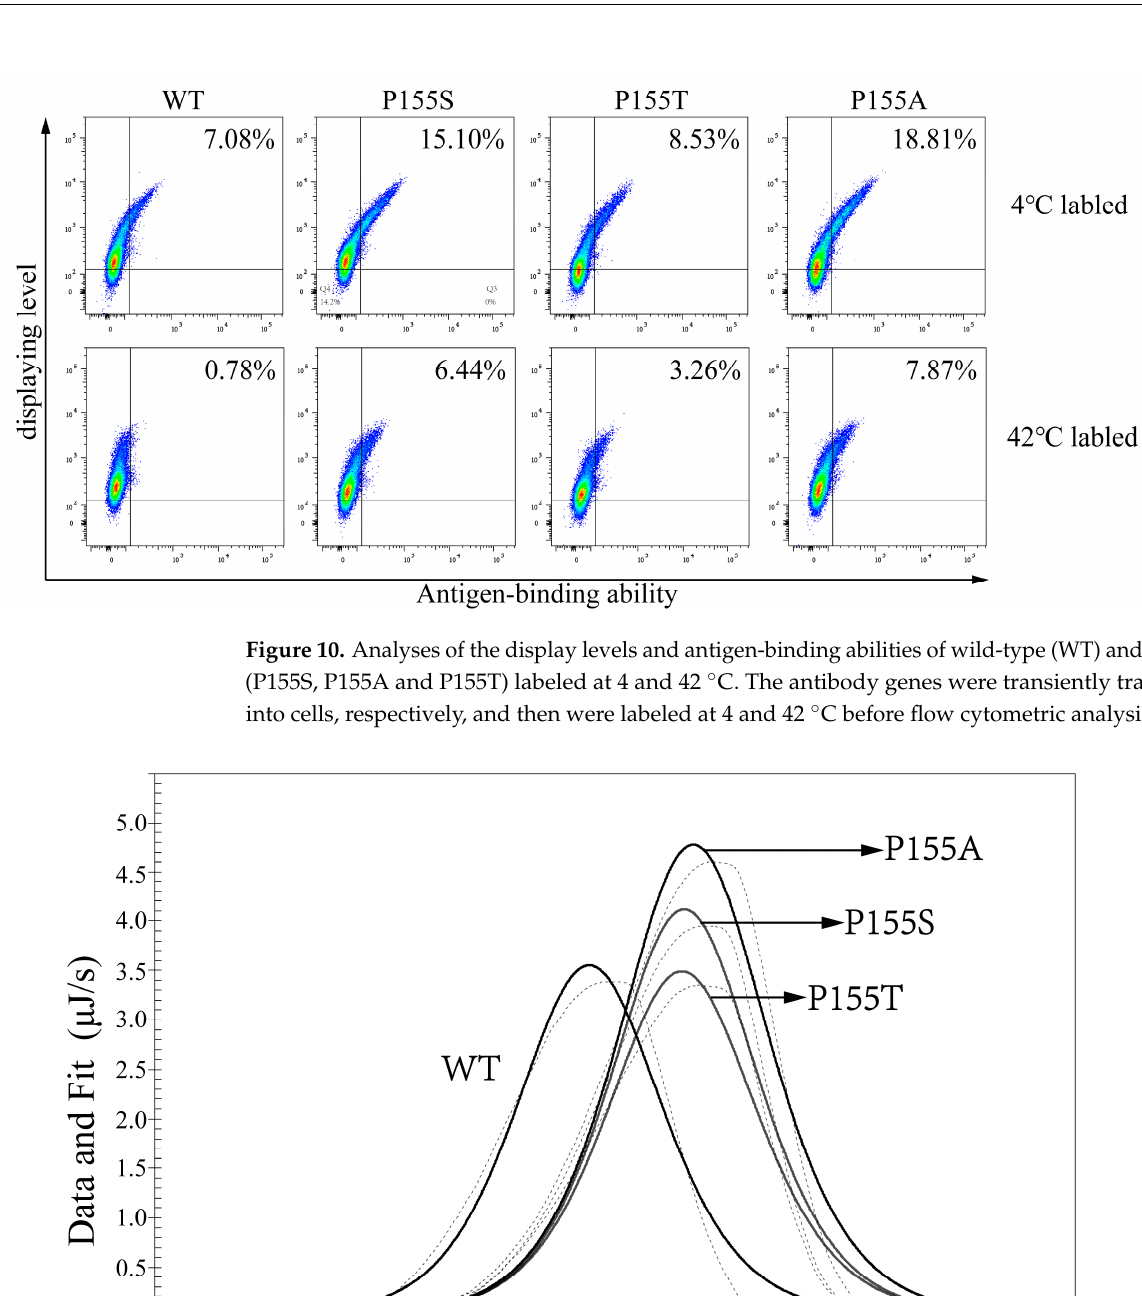
Figure 12. The modelling 3D structures of the antibodies. Green: wild-type antibody. Blue: P155A. Yellow: P155S. Gray: P155T. Pro at position 30 of heavy chain are highlighted by stick model. The nearby loops including CDR2 showed conformation changes induced by the residue substitutions at position 30. As for the anti-human kappa chain of CL, the five mutants S20N, S20N-A169T, S29N, T24N-K46N, and S86N-A169S were enriched. We synthesized the WT and these mutants in 293F cells. The cell culture volumes were 100 mL for either WT and all the mutants and yielded 3 mg WT and 12 mg mutant clones, respectively. The yields of these five mutants were obviously much higher than that of WT, but only one mutant (S86N-A169S) has a higher affinity and Tm (dissolution temperature) (Figures 13 and 14). The K D values of the WT and S86N-A169S were respectively 15.5 nM and 5.9 nM. The Tms of the WT and S86N- A169S were respectively 65.25 °C and 70.02 °C (Table 4).